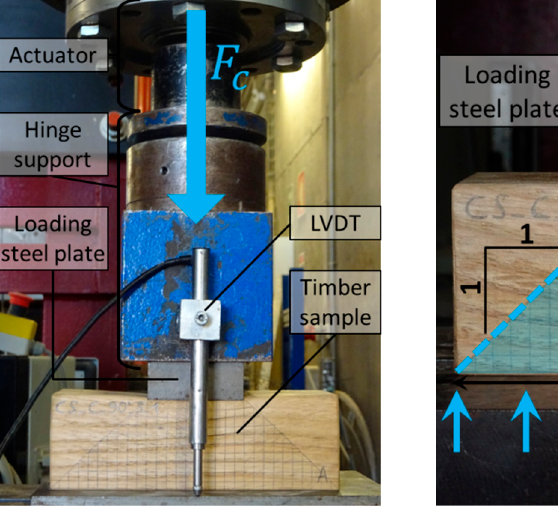
Figure 4. Setup required to apply the monotonic compression load 𝐹 (cid:3030) perpendicular to the grain ( a ). Compressive stress distribution 𝜎 (cid:3030) and vertical crushing 𝑤 assumed under the loaded area ( b ).